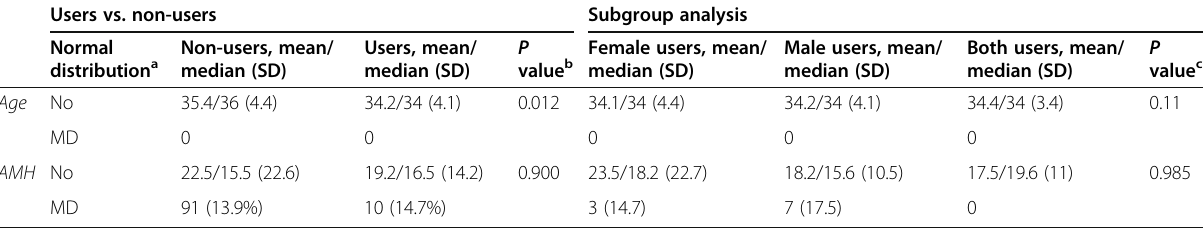
Table 1 Baseline demographic characteristics of 722 couples seeking IVF: median, standard deviation, missing data (MD), P value describing the difference between cannabis users and non-users including a subgroup analysis of the user group according to the identity of the user (female partner, male partner, or both). The data relates to the patient ’ s age and serum anti-Mullerian hormone (AMH) that represents the ovarian reserve at the time the IVF treatment was conducted Users vs. non-users Normal Non-users, mean/ distribution a median